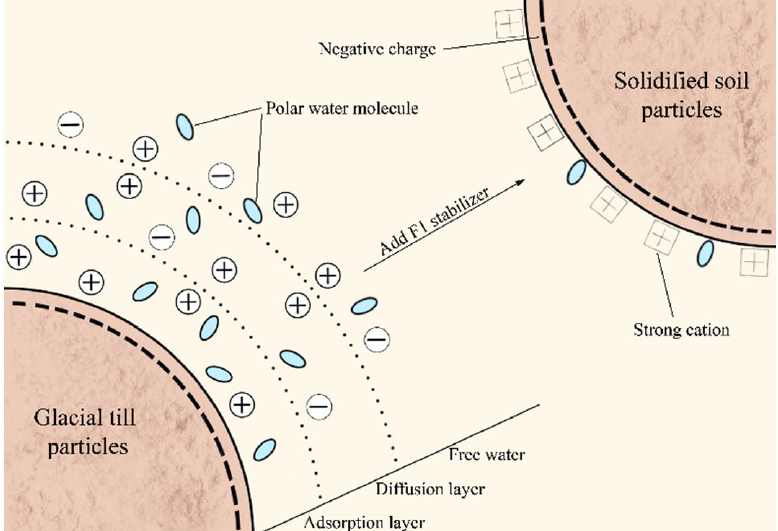
Figure 11. Schematic diagram of cation